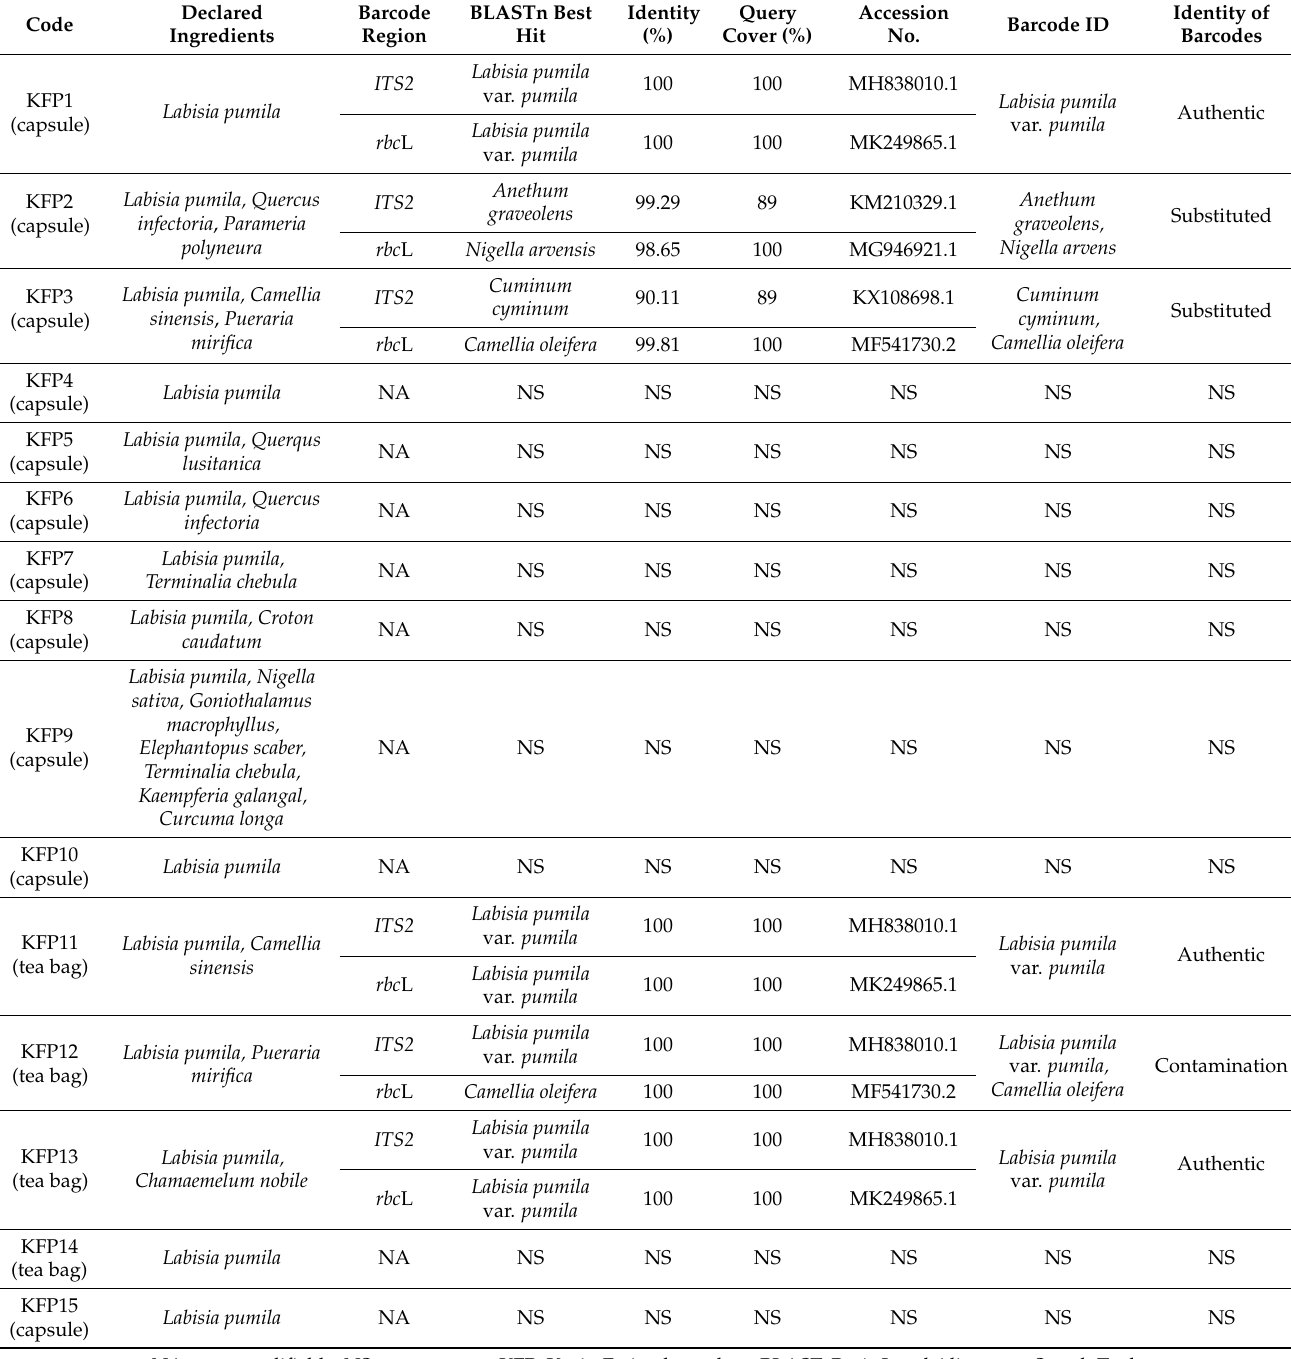
Table 1. Authentication summary of selected L. pumila herbal medicine products (HMPs) via DNA barcoding.